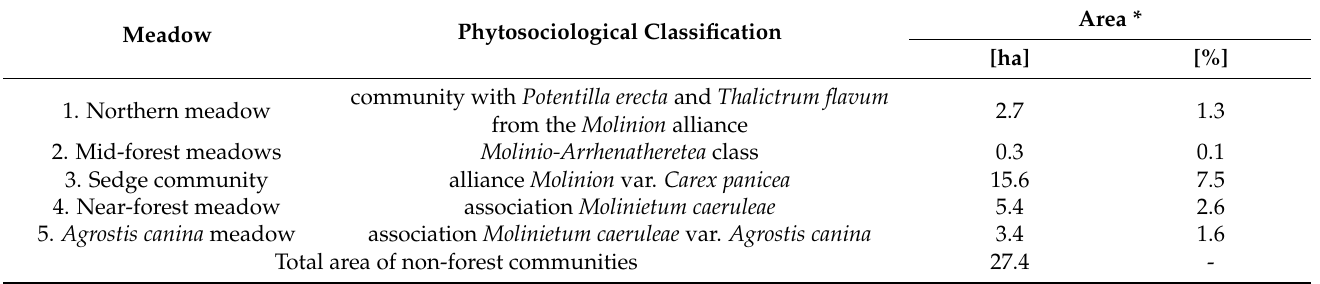
Figure 3. Percentage share of particular classes in the structure of phytocenosis grazed by Koniks in BNP; 1—northern meadow: community with Potentilla erecta and Thalictrum flavum from the Molinion alliance; 2—mid-forest meadows: communities from the Molinio-Arrhenatheretea class; 3—sedge community: alliance Molinion var. Carex panicea ; 4—near-forest meadow: association Molinietum caeruleae ; 5— Agrostis canina meadow: association Molinietum caeruleae var. Agrostis canina . Table 2. Areas with non-forest plant communities grazed by Koniks in the BNP.